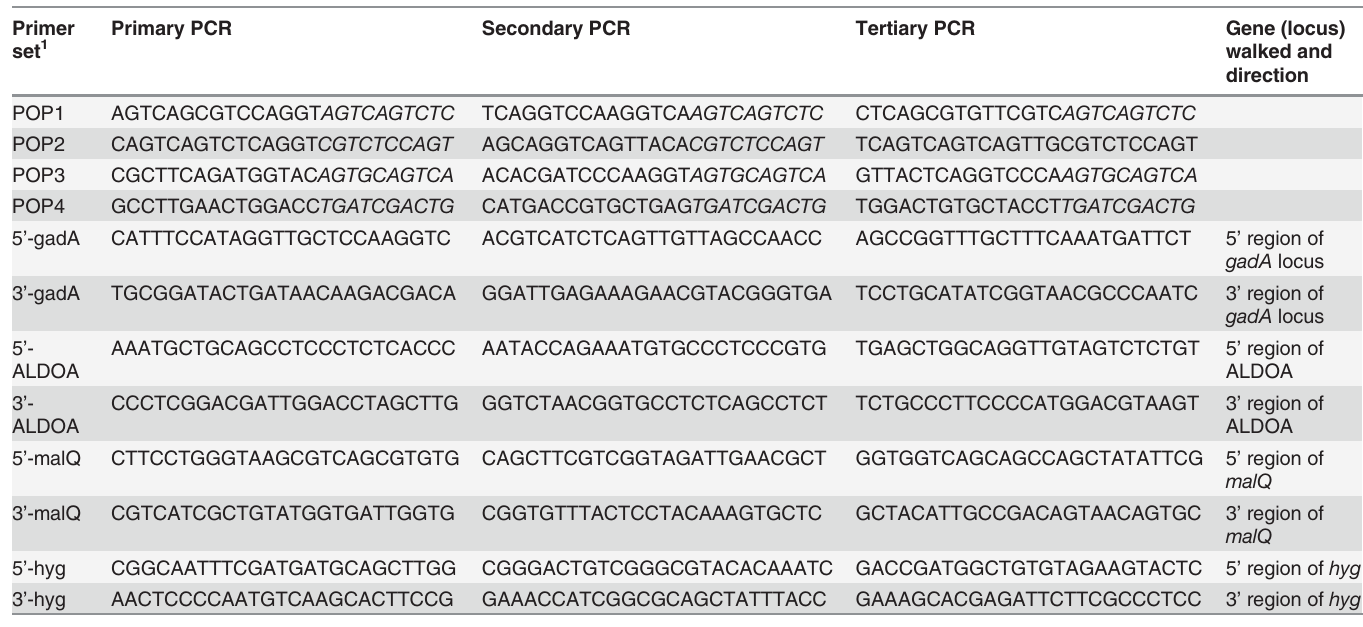
Table 1. Primers used in this study.